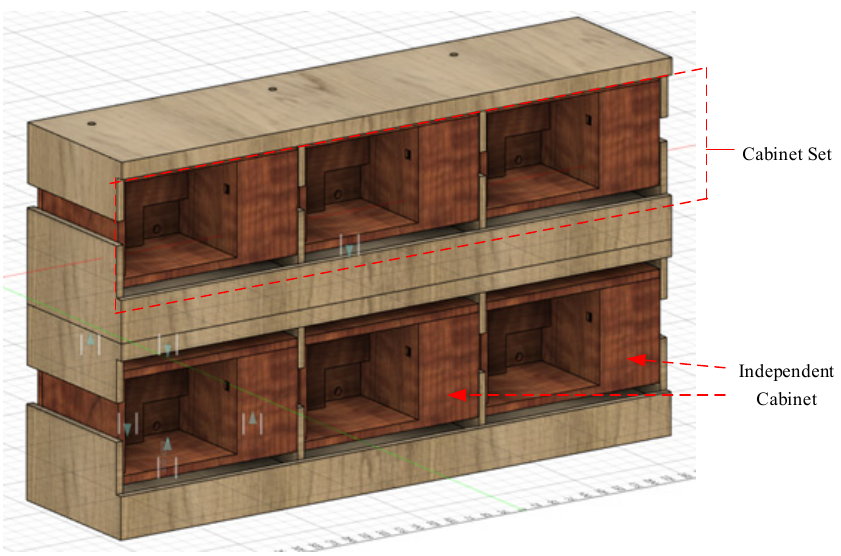
Figure 8. Three-dimensional design of key cabinet unit and independent key cabinet.